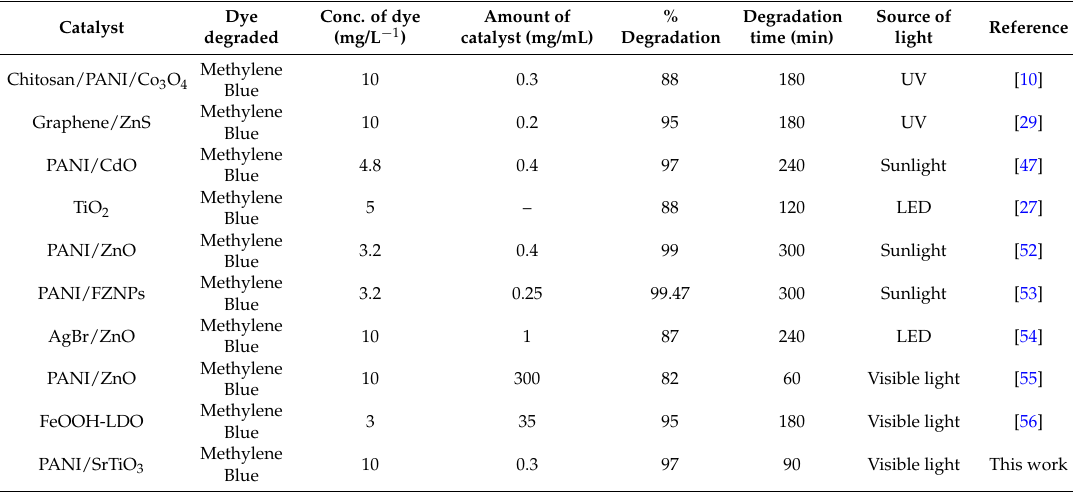
Table 1. Comparative study of the photocatalytic efficiencies of the different photocatalysts. Dye Catalyst